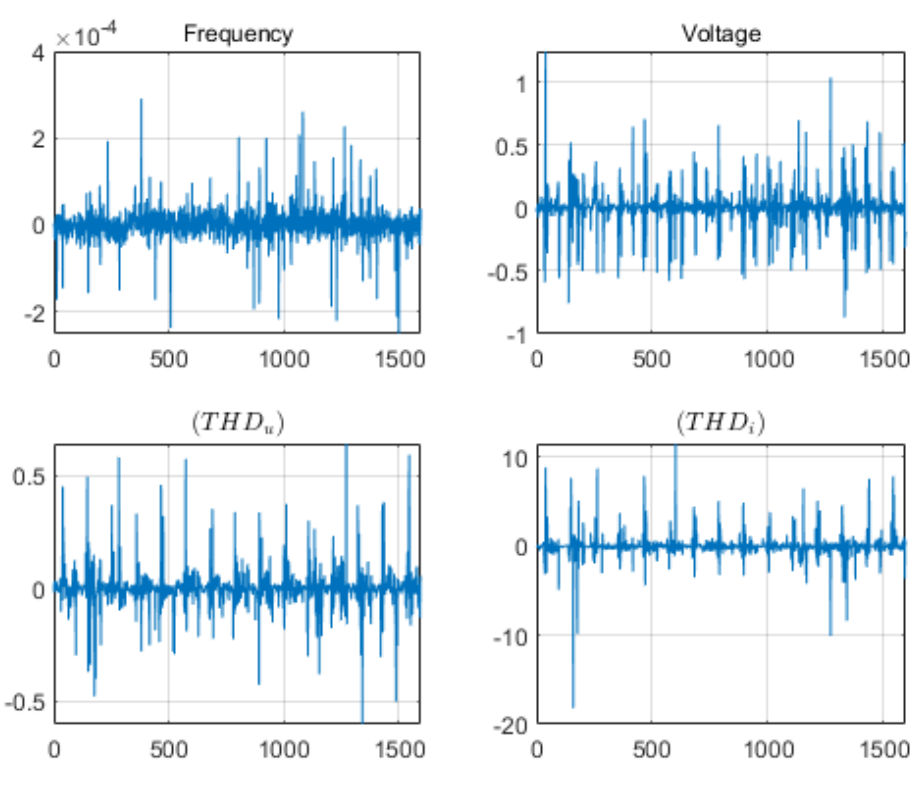
Figure 8. Residual results of the frequency, voltage, THD u , and THD i of the training phase of bagging DT.